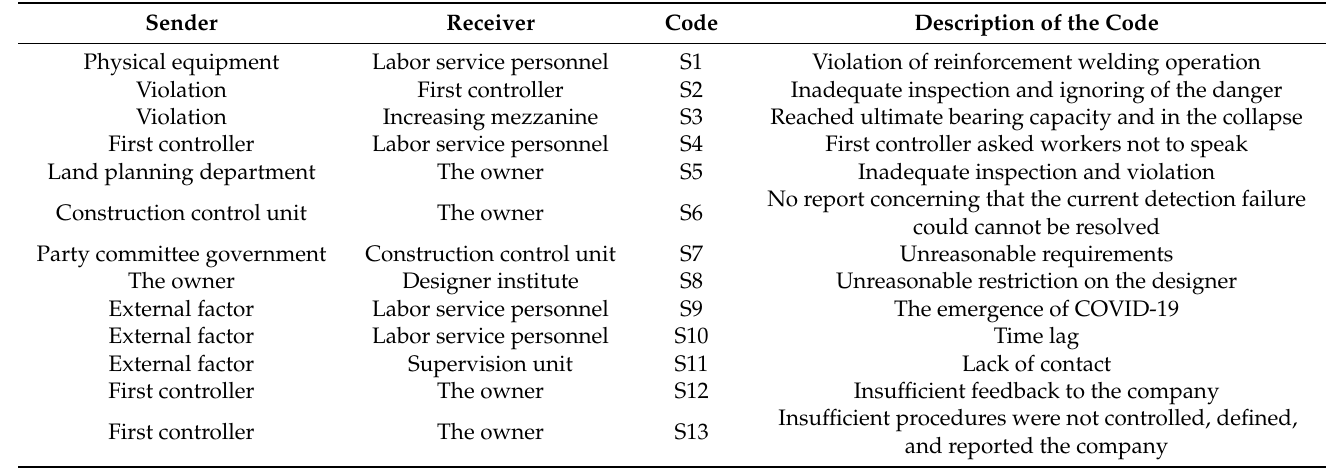
Table 3. Contributory factors of the